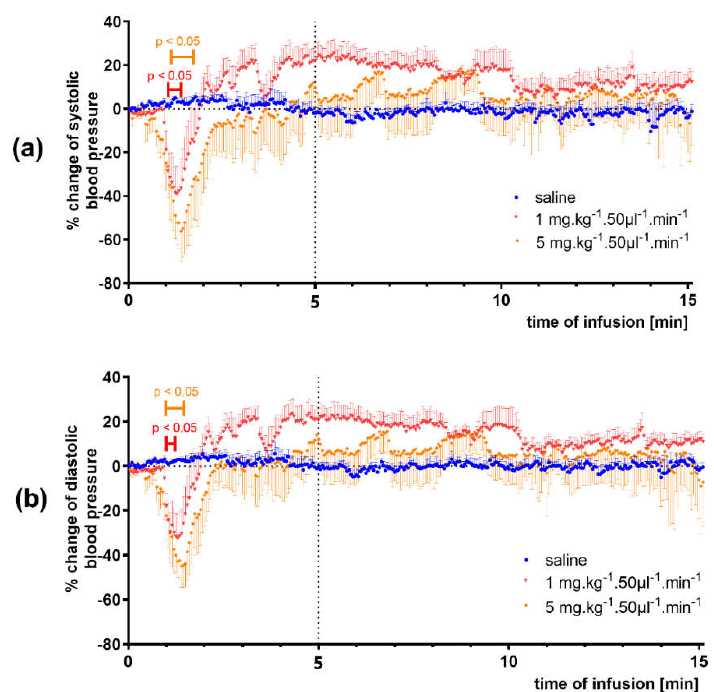
Figure 4. Effect of 3-hydroxyphenylacetic acid (1 and 5 mg · kg − 1 · min − 1 ) infusions on systolic blood pressure ( a ) and diastolic blood pressure ( b ) in spontaneously hypertensive rats ( n = 4). Significant change: p < 0.05.